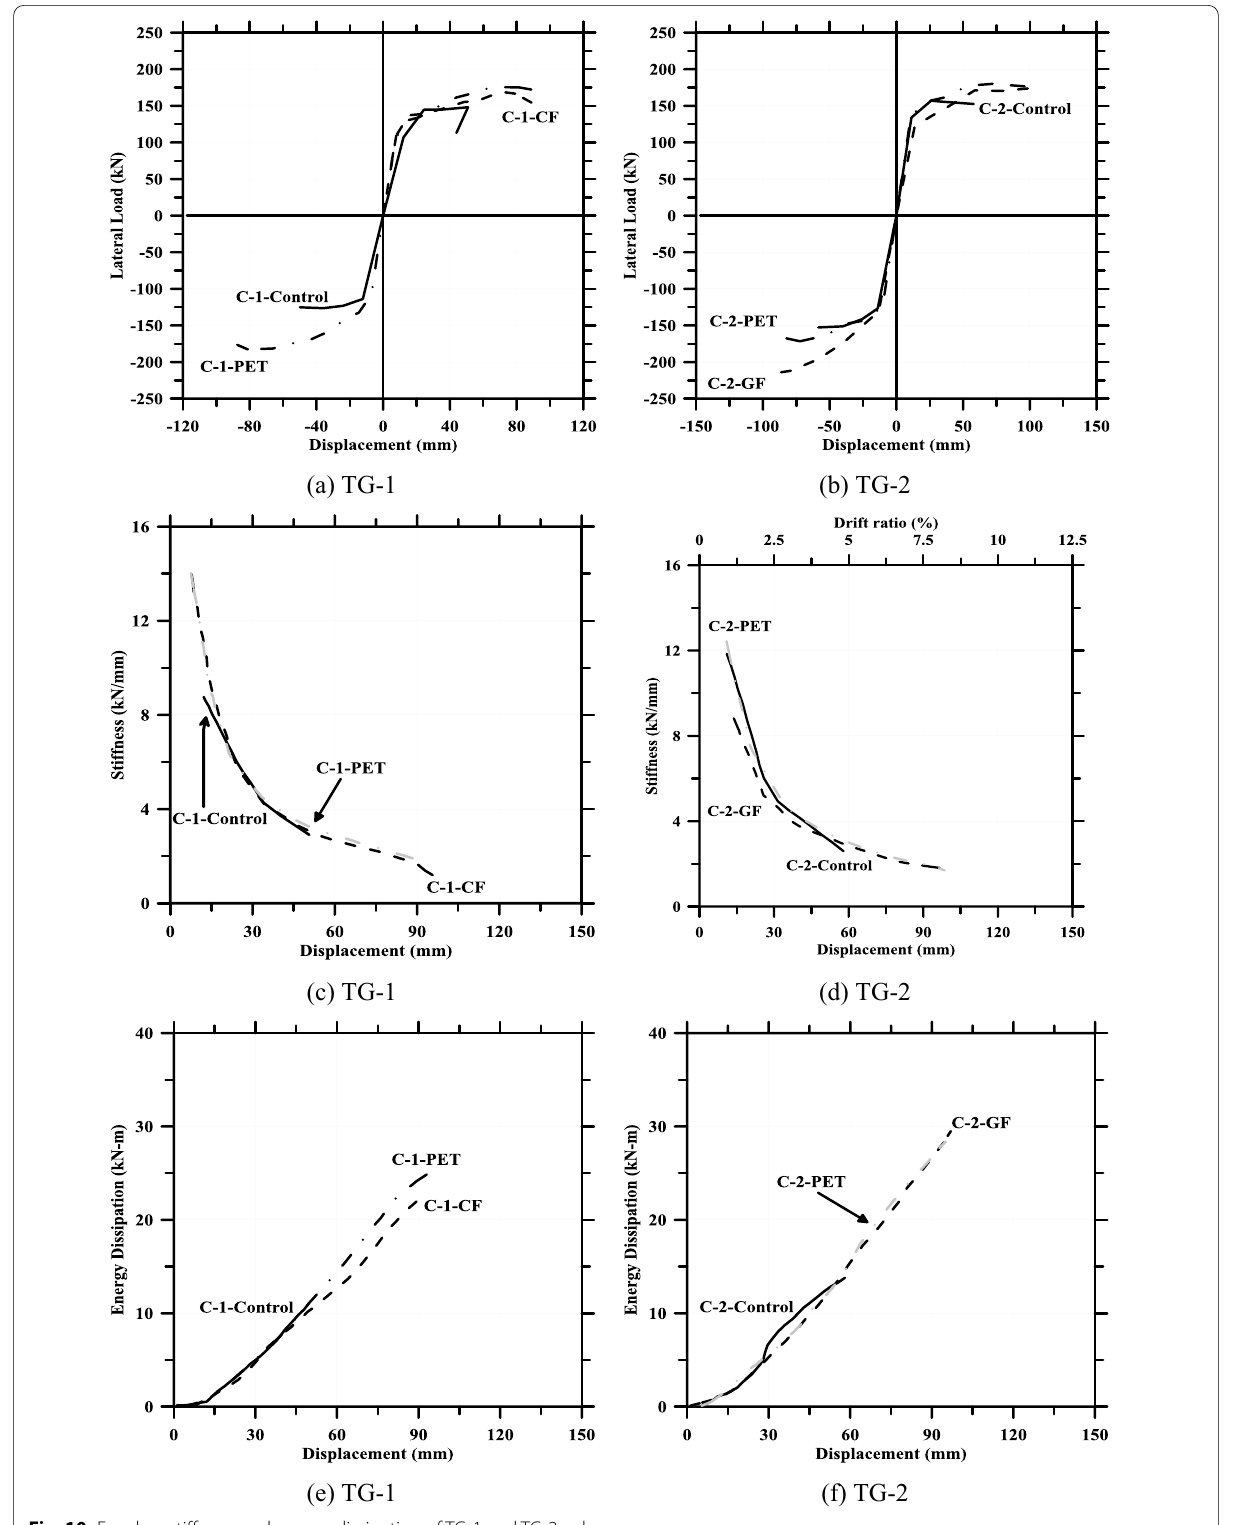
Fig. 10 Envelop, stiffness, and energy dissipation of TG‑1 and TG‑2